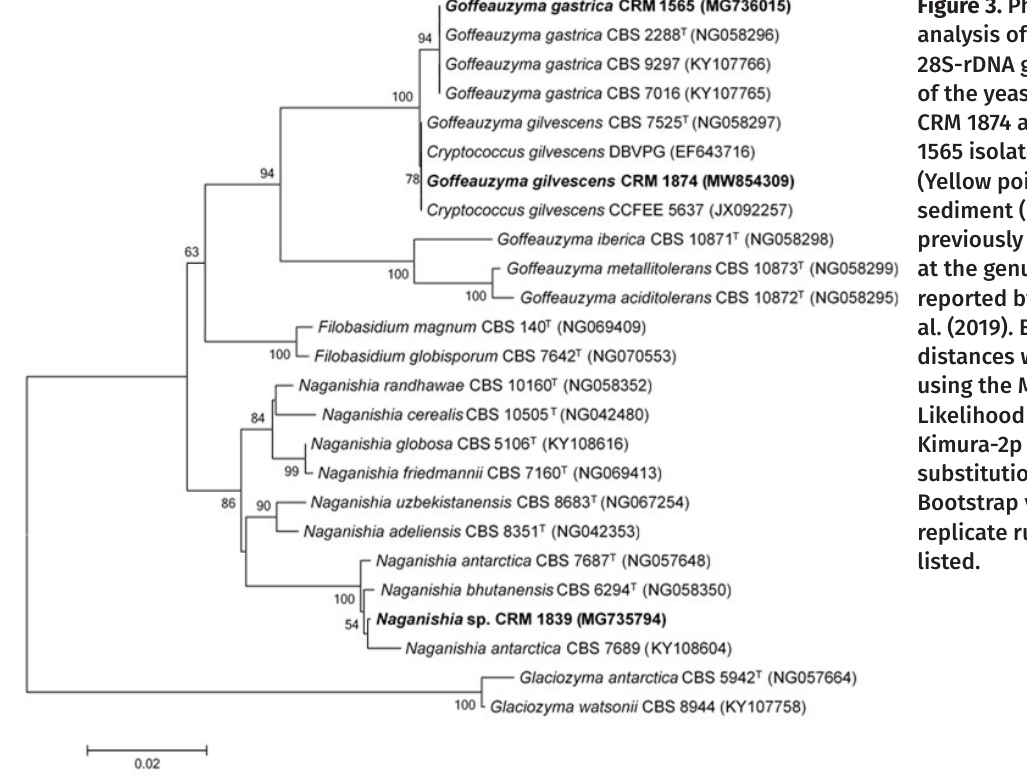
Figure 3. Phylogenetic analysis of